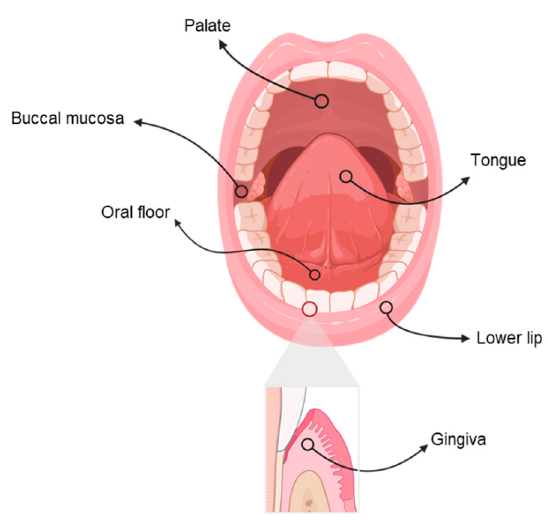
Figure 2. The most common sites of oral cancer.